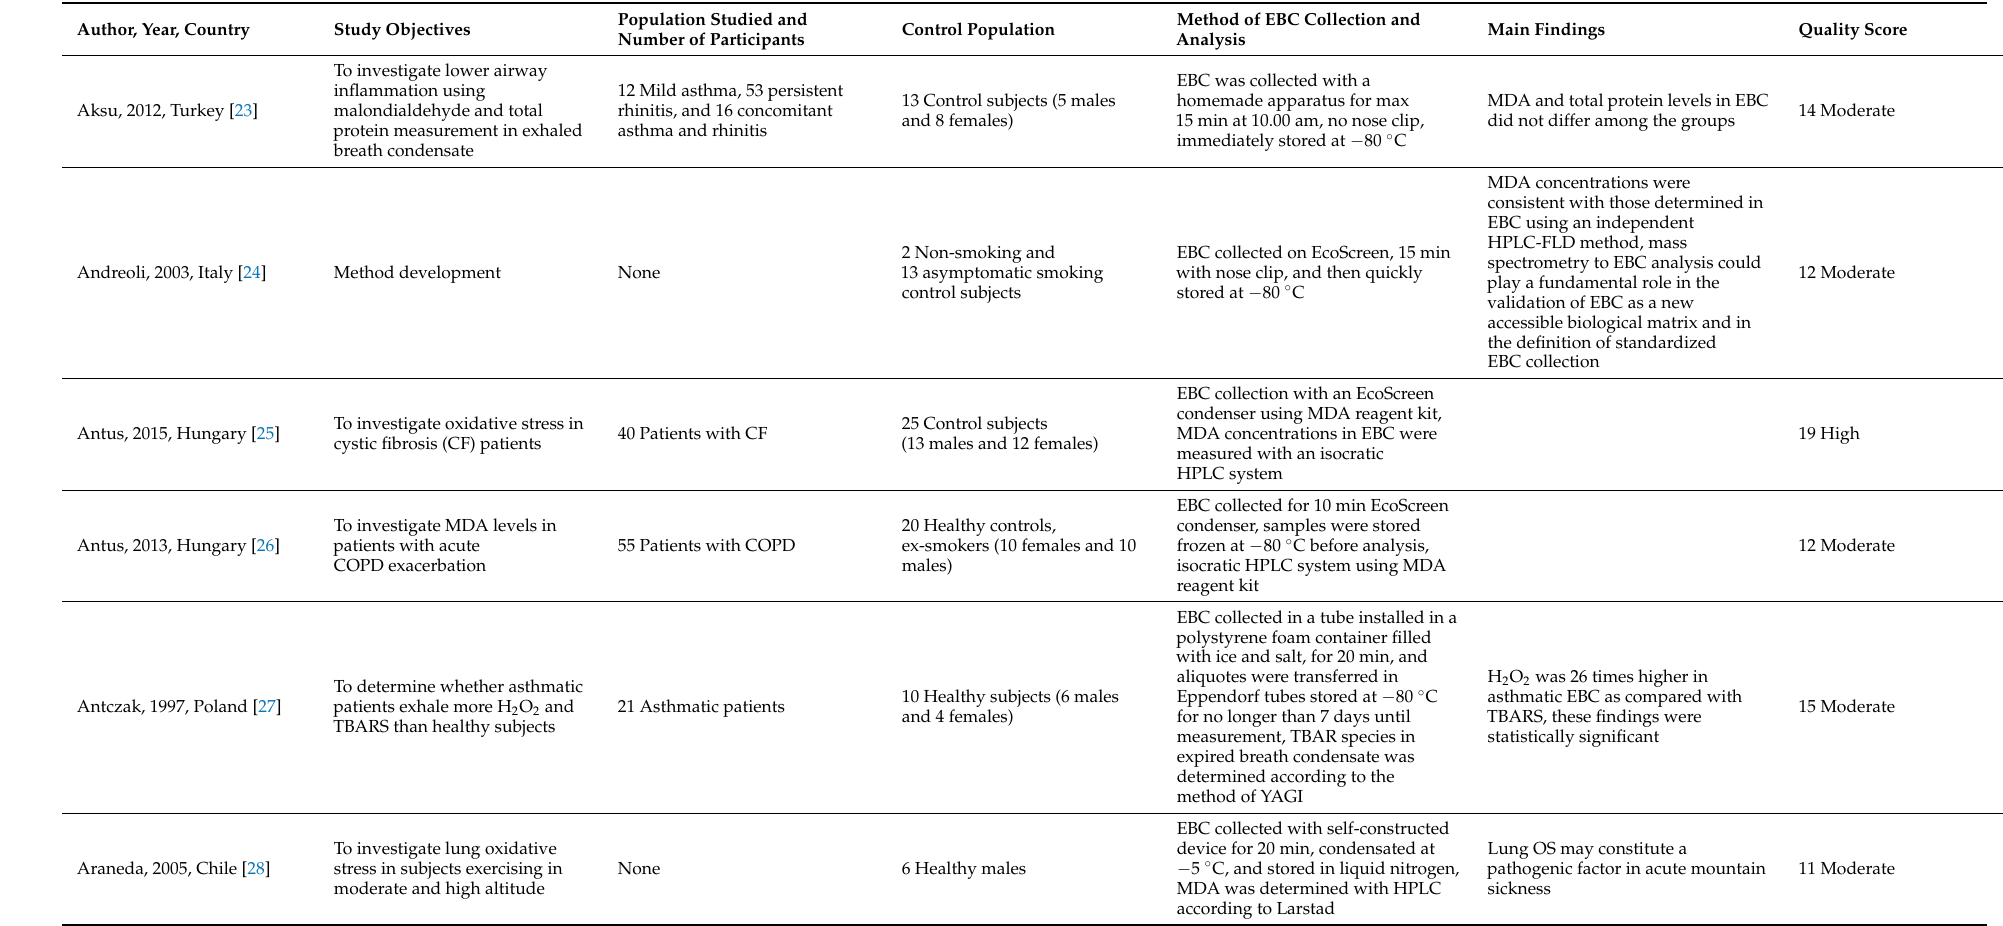
Table 1. Qualitative synthesis of articles that underwent data